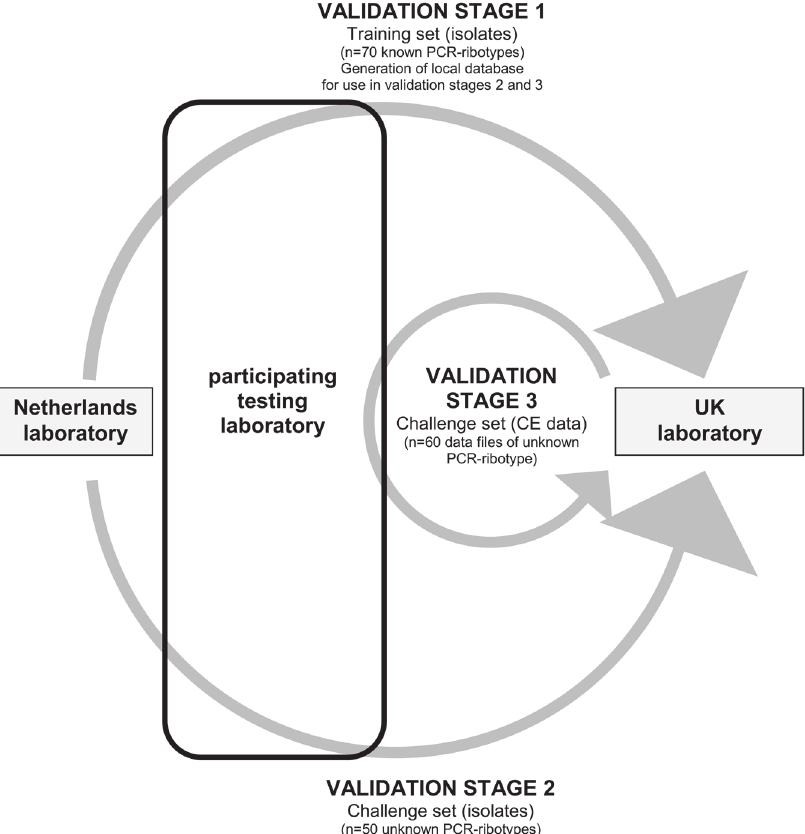
Fig 1. Process for multi-centre consensus method validation. STAGE 1: 70 well characterised ribotypes disseminated from Netherlands to each laboratory for ribotyping (data (i) held locally for future comparsion/ ribotype assignment, (ii) sent to UK laboratory); STAGE 2: 50 anonymised isolates disseminated from Netherlands to each laboratory for ribotype identification (assignments sent to UK laboratory for analysis); STAGE 3: 60 anonymised data files disseminated from UK to each laboratory for ribotype identification (assignments sent to UK for analysis).